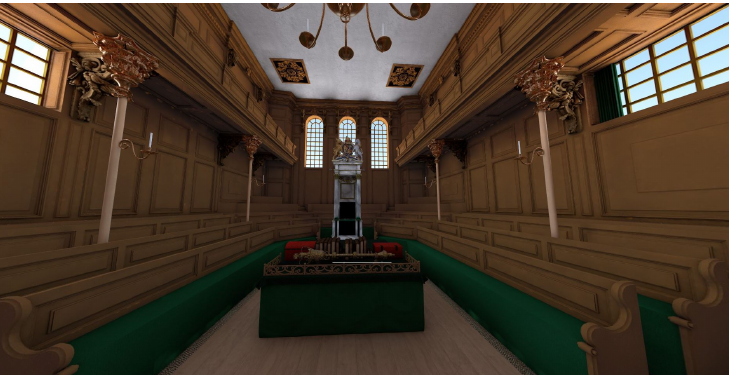
Figure 3. The House of Commons Remodelled, 1692–1707, St Stephen’s Chapel Westminster Project 2017, image from [14].